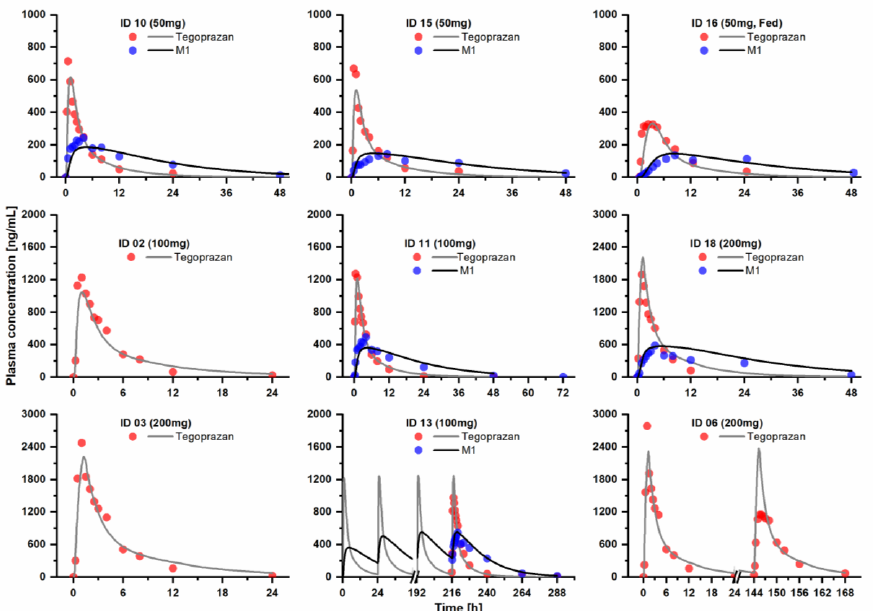
Figure 2. In terms of the test dataset, the predicted and observed plasma concentration – time curves of tegoprazan and the metabolite M1 after the oral administration of tegoprazan in healthy subjects are shown. Solid lines are the predicted values of each model. Circles are clinical observations. Details on dosing regimens, characteristics, subject demographics, and references are listed in Table S1.